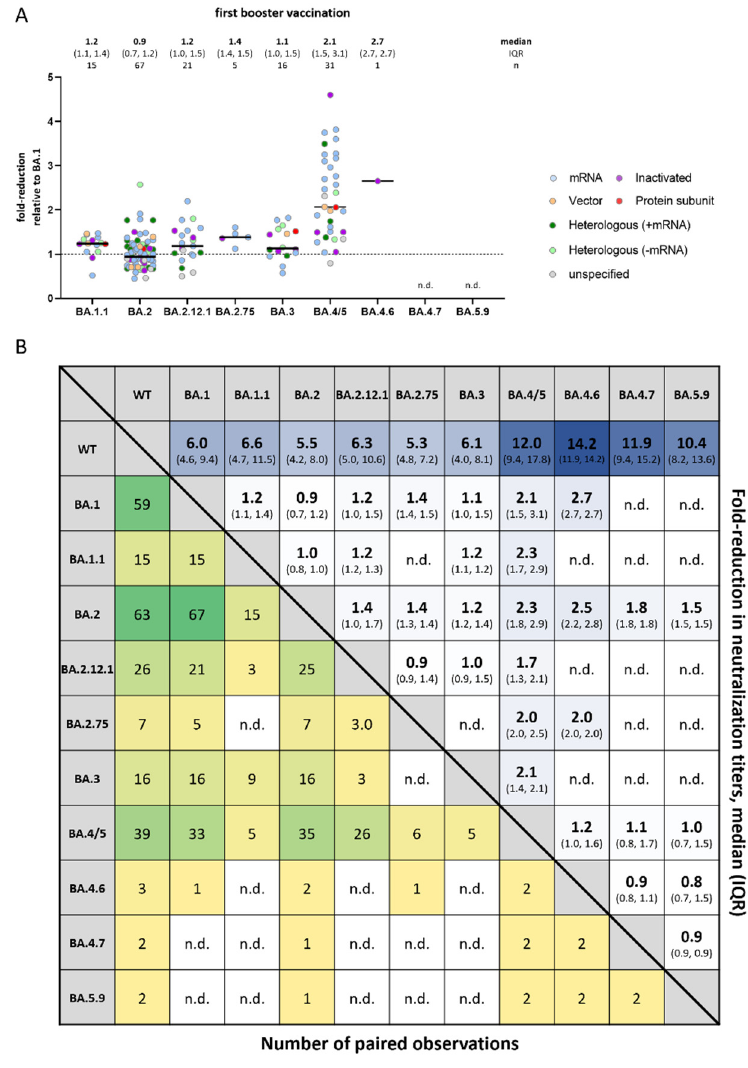
Figure 3. Relative fold-reduction in neutralization titers across Omicron sub-variants. Reported fold-change in neutralization titers of Omicron sub-variants compared to Omicron BA.1 ( A ) and for each sub-variant to each-other ( B ). Only studies with at least two sub-variant specific and matched observations are shown. Median and IQR (upper right corner) and number of paired observations (lower left corner) is shown. n.d. = no data.